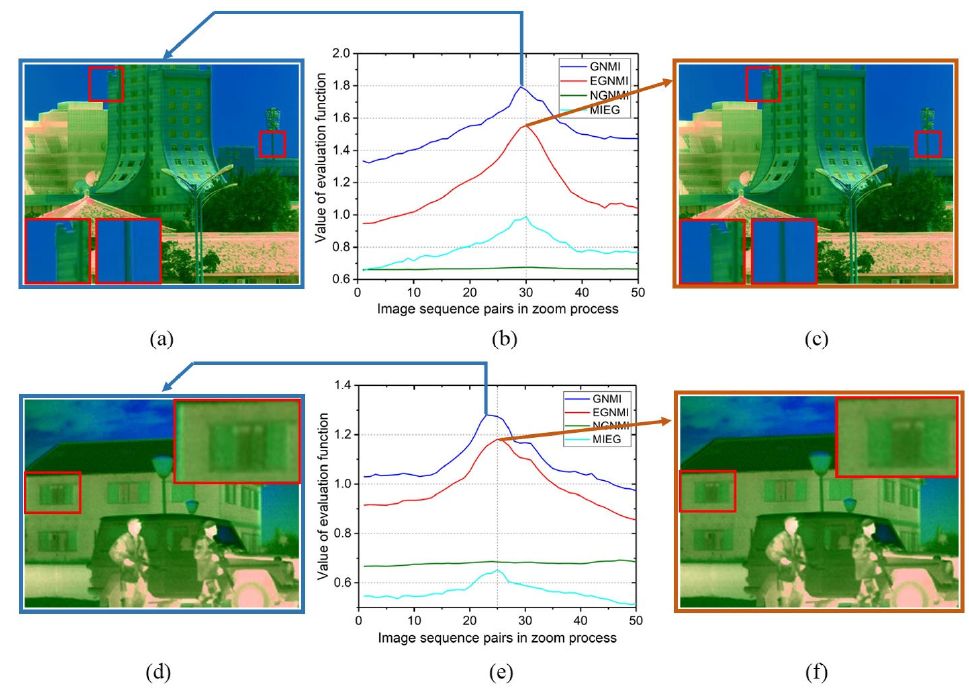
Figure 10. Fusion image matching comparison of different peak values in two scenes (the details in red boxes are enlarged to display): ( a ) frame 29 in Scene 1; ( b ) evaluation function in Scene 1; ( c ) frame 30 in Scene 1; ( d ) frame 23 in Scene 4; ( e ) evaluation function in Scene 4; and ( f ) frame 25 in Scene 4.